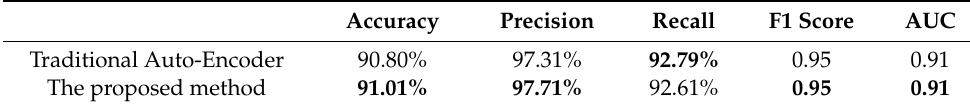
Table 7. The results of the developed method and the traditional Auto-Encoder. Accuracy Precision Recall F1 Score AUC Traditional Auto-Encoder